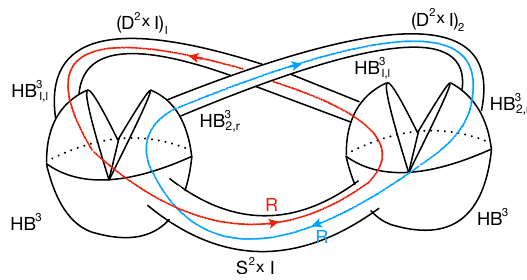
Figure 27 . Geometric representation of the reduced density matrix.